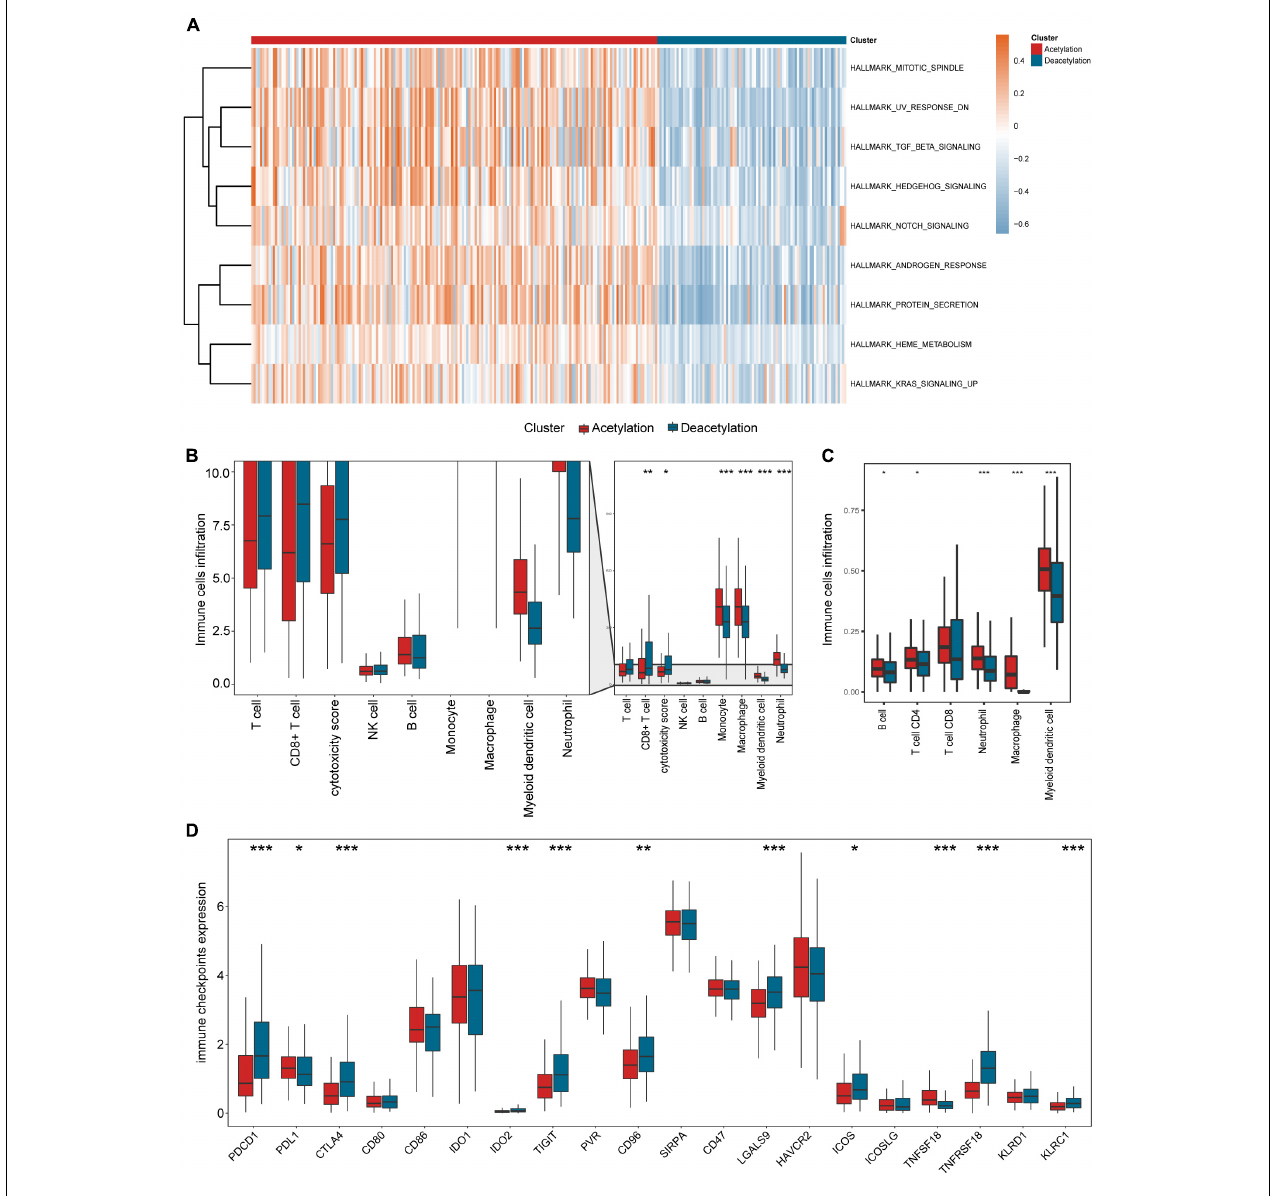
FIGURE 4 | Relevant signaling pathways, immune cell infiltration, and immune checkpoints in subtypes. (A) The results of gene set variation analysis. (B,C) Comparisons of immune cell infiltration between two subtypes. (D) Comparison of immune checkpoints expression between two subtypes. In panels (B–D) , * p < 0.05, ** p < 0.01, *** p <